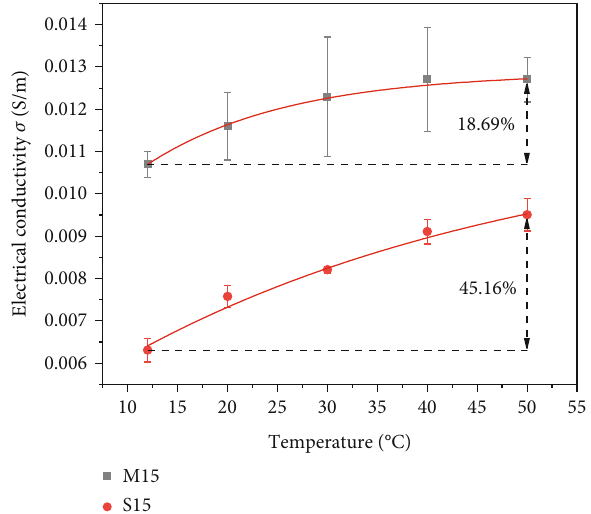
Figure 8: Variation of conductivity of MWCNTs/CM with temperature and MWCNTs